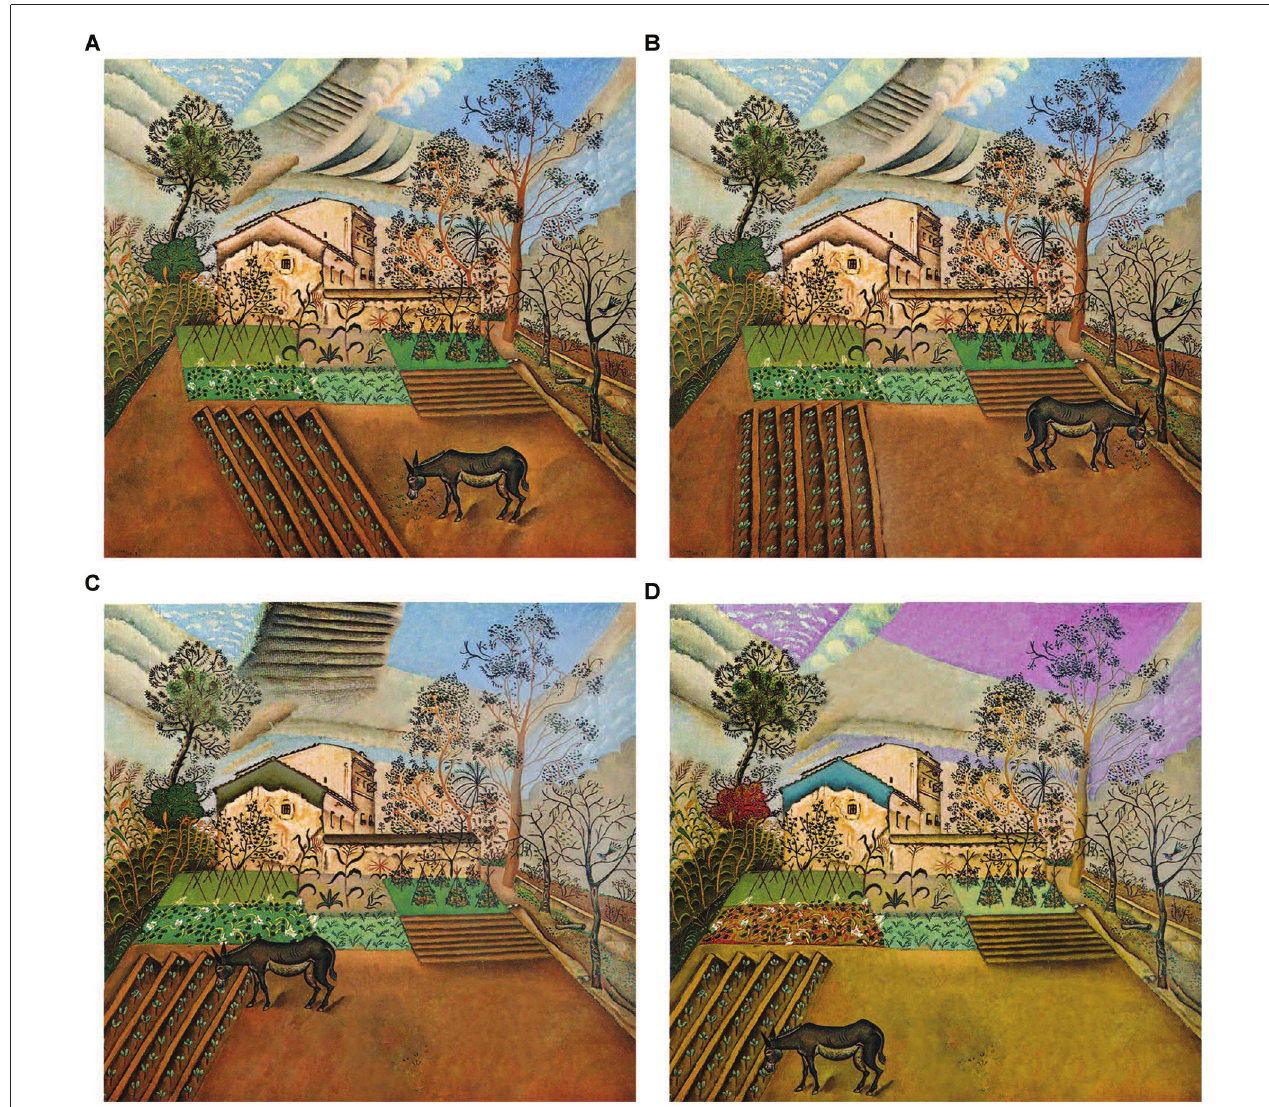
FIGURE 2 | (A) Joan Miro, The Vegetable Garden with Donkey , 1918, oil on canvas, 70 × 64 cm, Moderna Museet, Stockholm, Sweden, (B) slightly modified version of (A) , (C) moderately modified version of (A) , (D) significantly modified version of (A) .